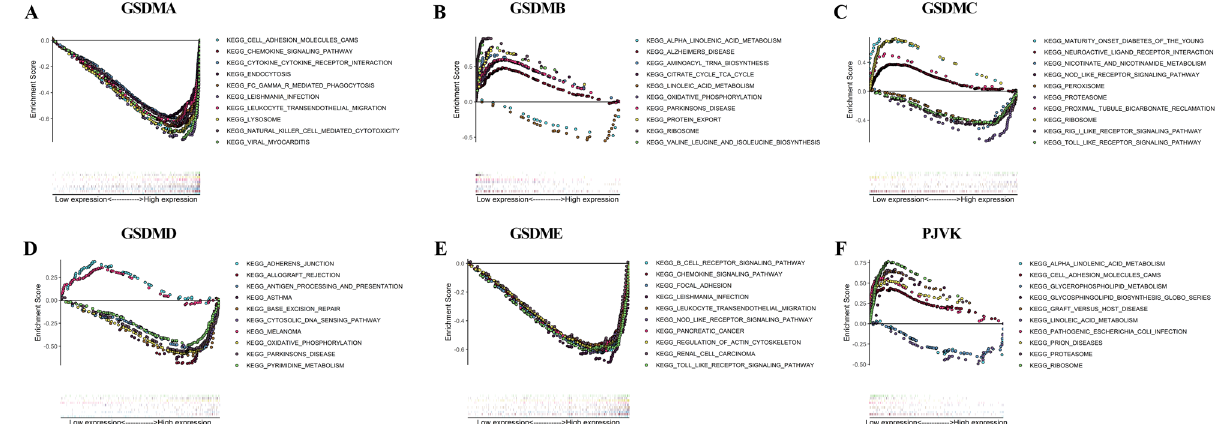
Figure 12. Gene set enrichment analysis (GSEA) of gasdermin family gene associated with signaling pathways in KEGG dataset. GSDMA ( A ), GSDMB ( B ), GSDMC ( C ), GSDMD ( D ), GSDME ( E ), and PJVK ( F ). Each line representing one particular signaling pathway with unique color, and low-expressed genes lay on the left approaching the origin of the coordinates, and the high-expressed located in the right of